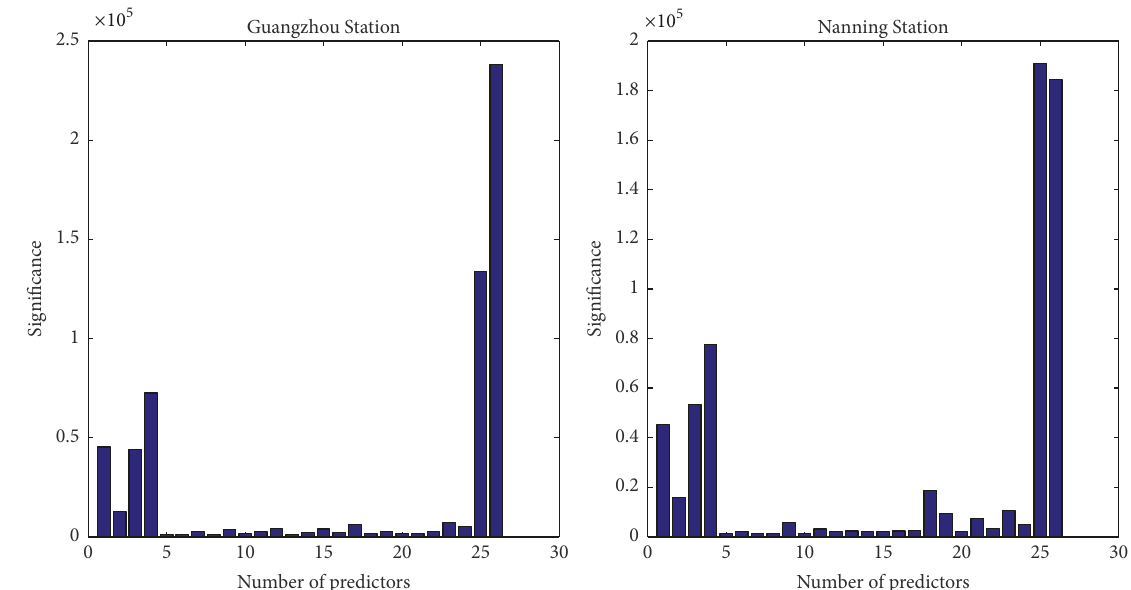
Figure 4: Relative significance of the predictors at Guangzhou Station and Nanning